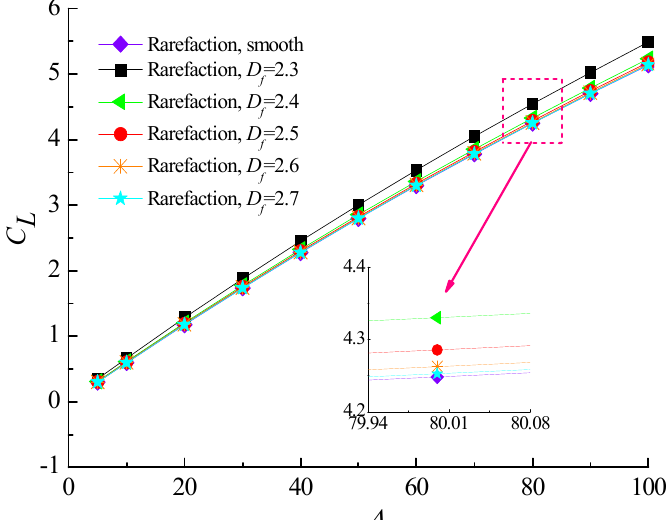
Figure 9. Non-dimensional load capacity versus bearing number for different fractal dimensions at ε = 0.6, G = 1 × 10 − 10 .